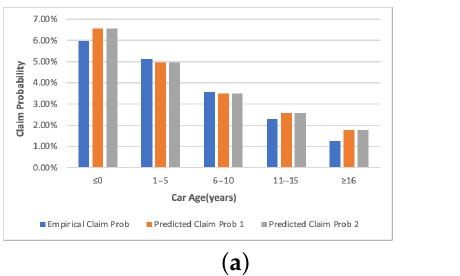
Figure 2. Comparison of empirical and the predicted values of claim probability and loss cost by different age groups. ( a ) presents the results of claim probability. ( b ) corresponds to the loss cost. The orange bar shows results for predictions without using clusters. The grey bar presents results for predictions with designed clusters.